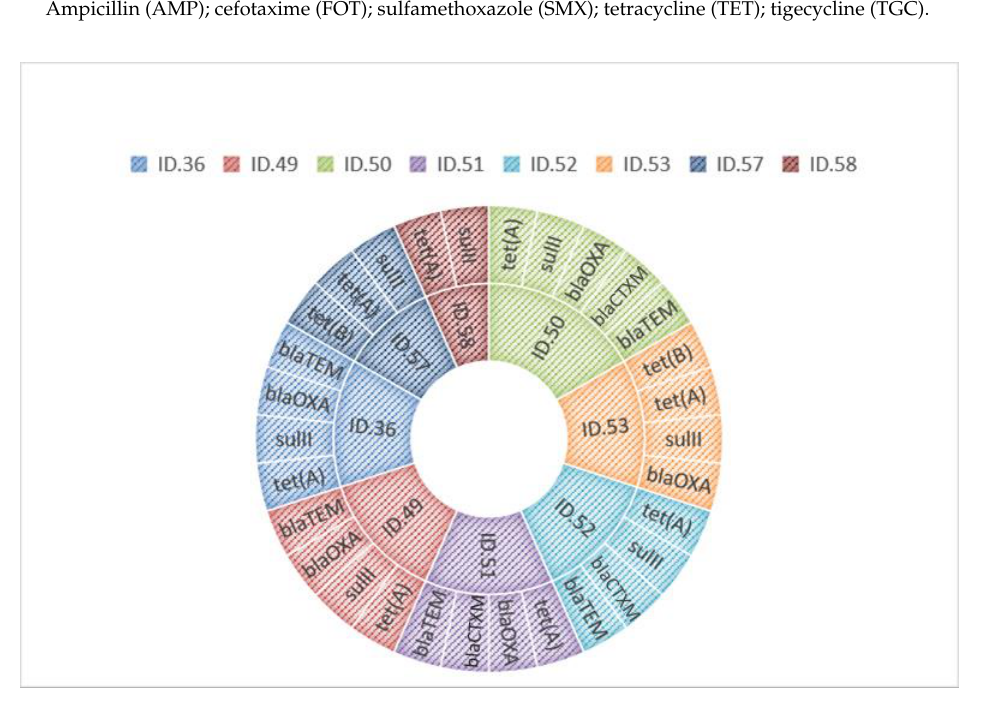
Figure 1. ARGs harbored by each MDR strain.